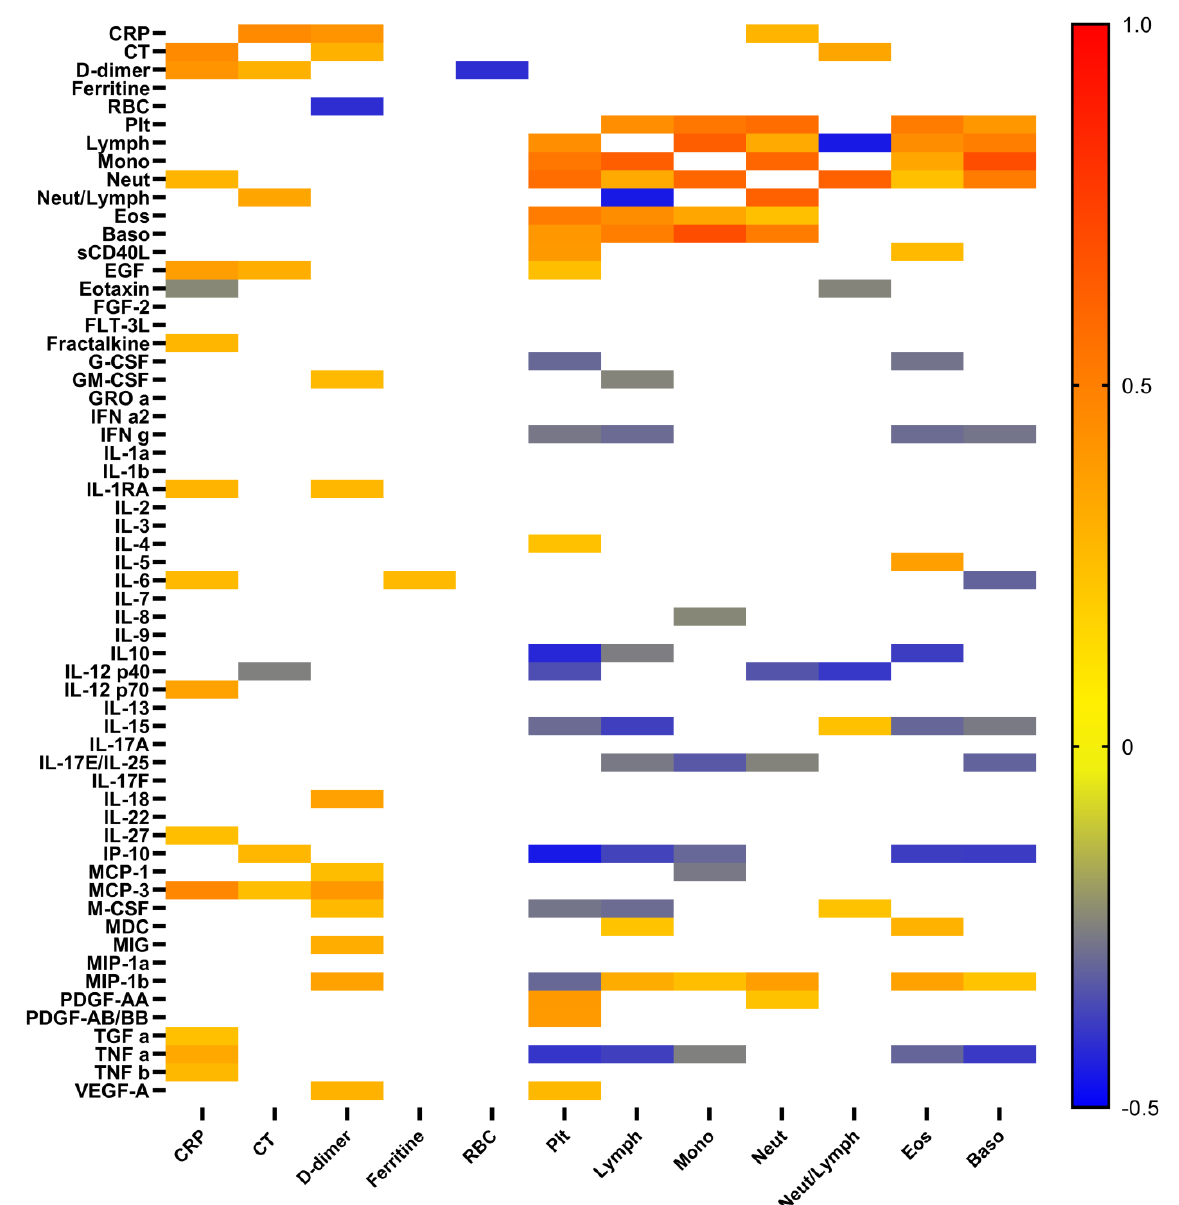
Figure 3. Heat map of correlations between cytokine levels, and some conventional clinical and laboratory markers in patients with COVID-19. Color scale bar show a range of correlation coefficient (r). The red color represents a high positive correlation, decreasing to the blue color bar, which represents a negative correlation.